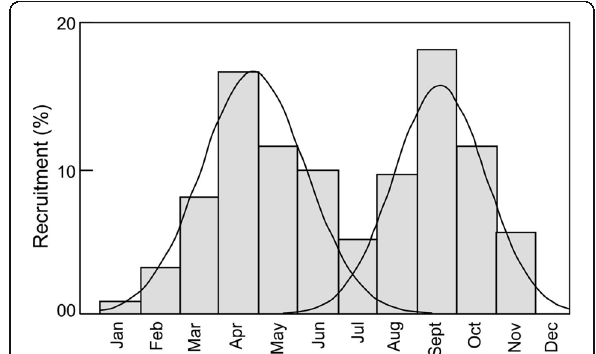
Fig. 6 Recruitment pattern for Pachypterus khavalchor from the Panchaganga River, Maharashtra,